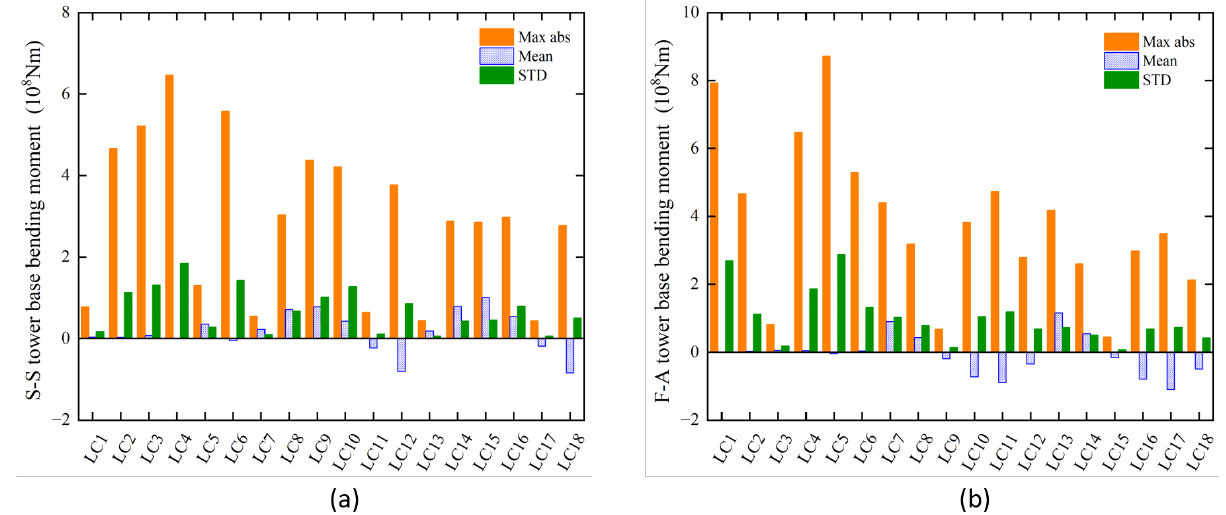
Figure 14. The bending moment of ( a ) F-A tower base, ( b ) S-S tower base for all the considered load cases.